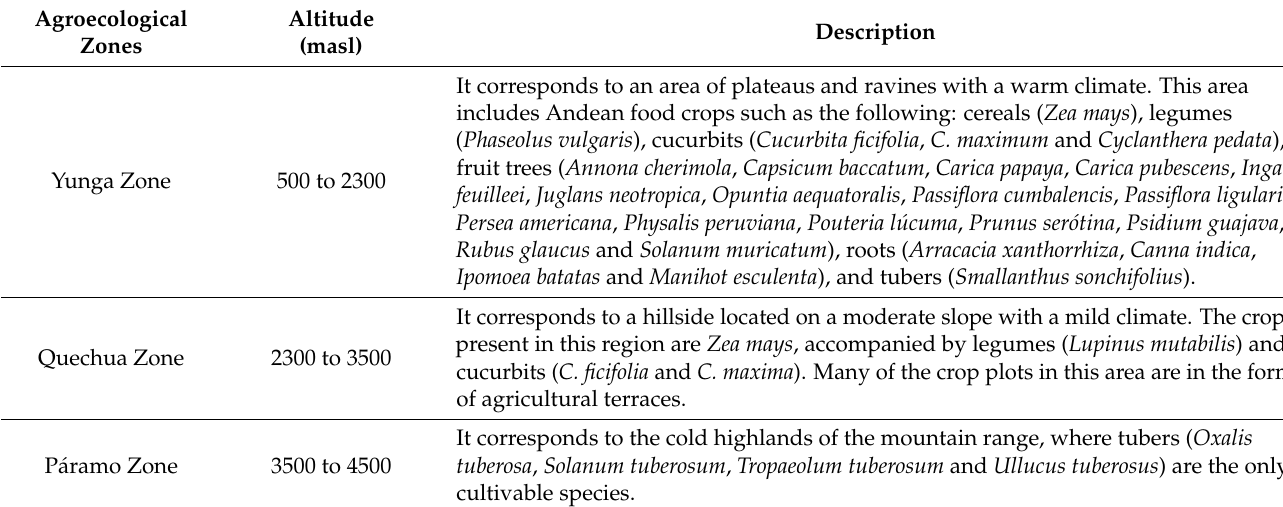
Table 2. Agroecological zones recorded in the Chanch á n